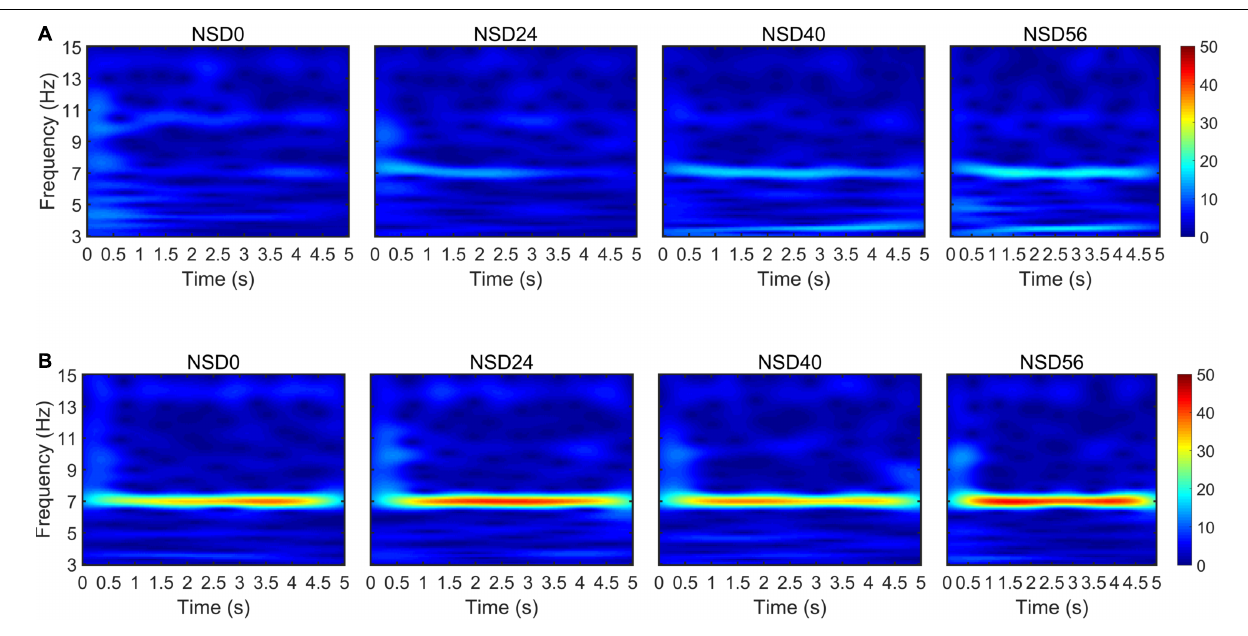
FIGURE 7 | Time-frequency analysis results of SSVMEP signals based on a complex Morlet CWT with a time-window length of 5 s (i.e., 6000 sampling points). (A) Time-frequency graph of SSMVEP signals at an MRF of 7 Hz under different NSD values in the single ring paradigm. (B) Time-frequency graph of SSMVEP signals at an MRF of 7 Hz under different NSD values in the checkerboard